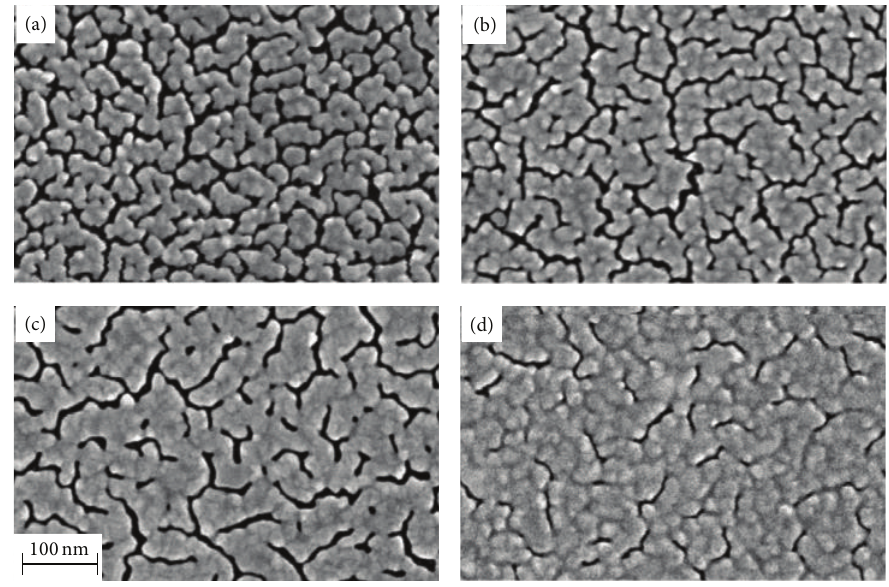
Figure 2: SEM images of Au films directly deposited on a flat dielectric substrate. The film thickness is 8, 10, 11, and 15nm in (a), (b), (c), and (d), respectively.